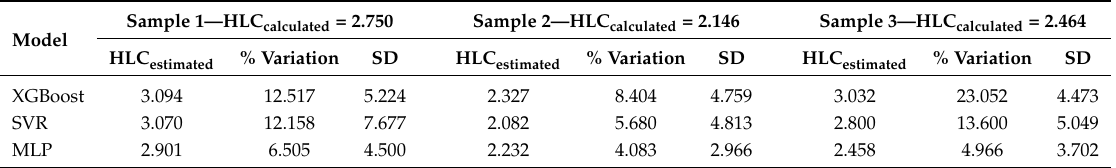
Table 4. Numerical results of the HLC estimations for all validation samples. The values shown summarize the performance of each of the models through 10 repetitions of the experiment. The mean of the absolute variation rates (together with the standard deviation), the mean of the estimated HLC values and the calculated HLC are